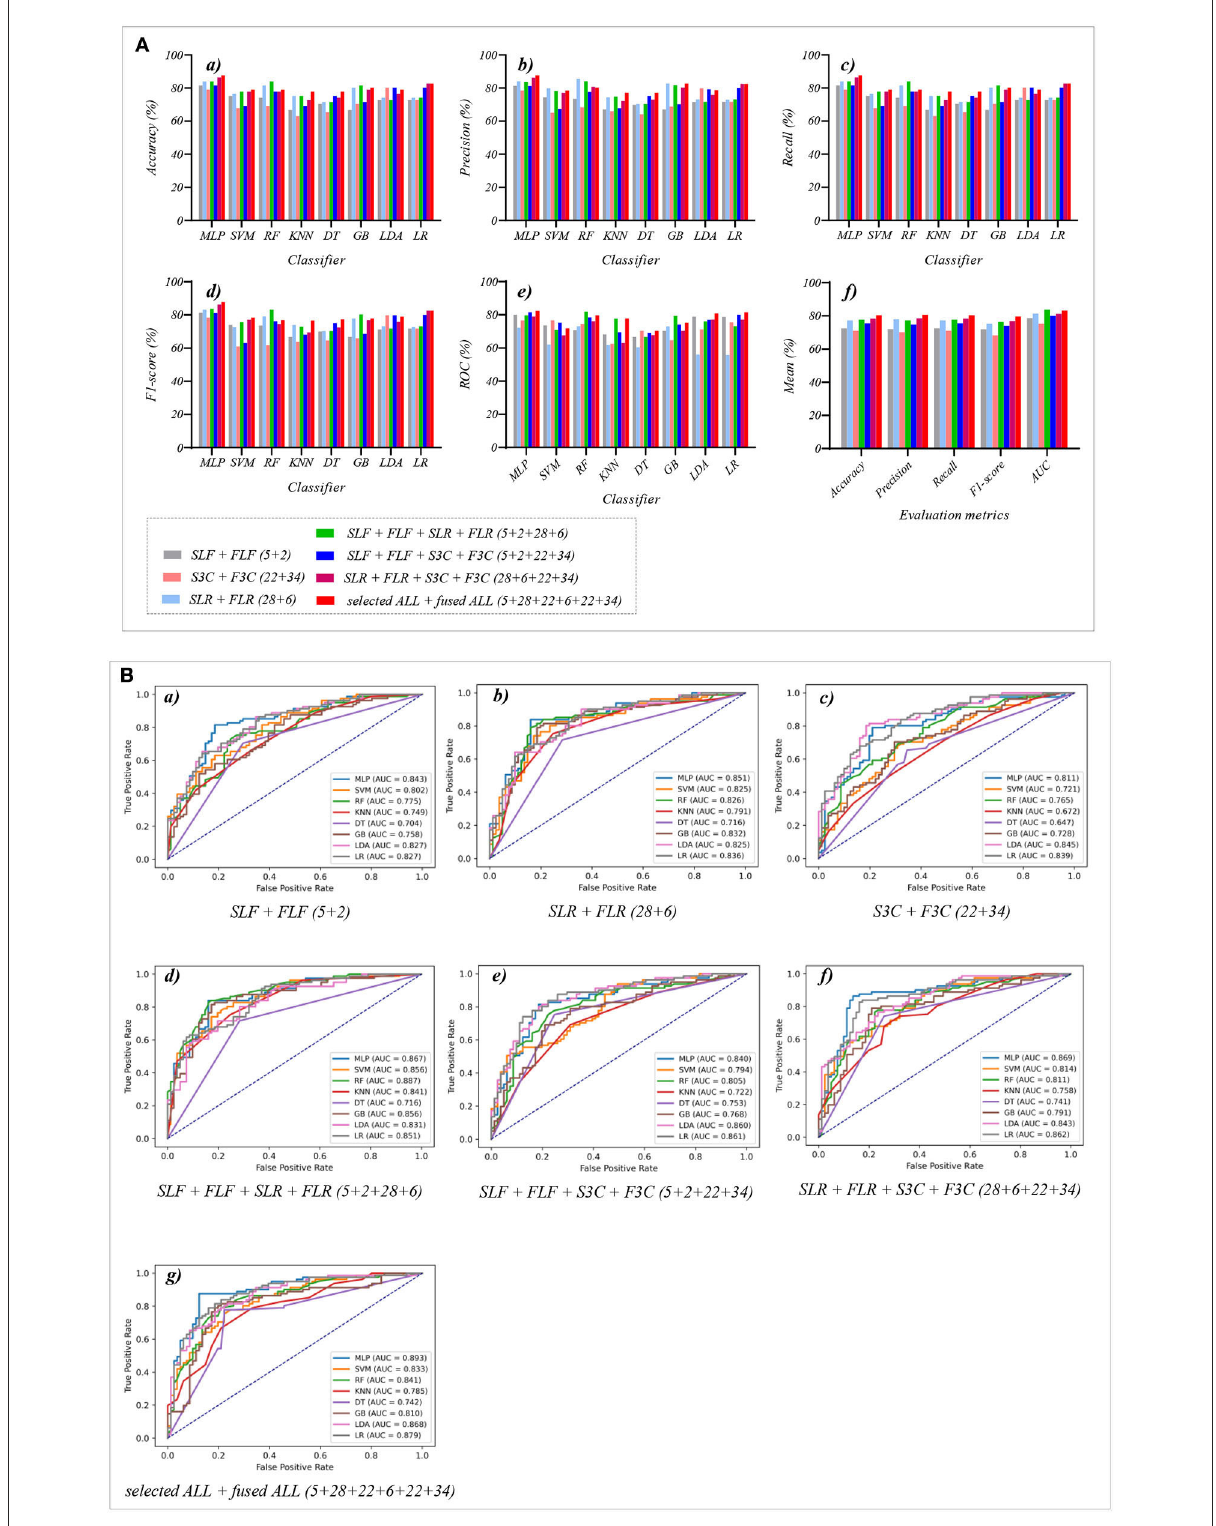
FIGURE7 The evaluation metrics pictures and ROCs of eight classifiers with seven selected and fused combination features (Experiment 4). (A) The evaluation metrics pictures include (a) Accuracy, (b) Precision, (c) Recall, (d) F1-score, (e) AUC, and (f) Mean. (B) ROCs of the ML classifiers include (a) SLF FLF (5 2), (b) SLR FLR (28 6), (c) S3C F3C (22 + + + + + (5 2 22 34), (f) SLR FLR S3C F3C (28 6 22 34), and (g) SLF + + + + + + + + + 5 2 28 6 22 + + + + +